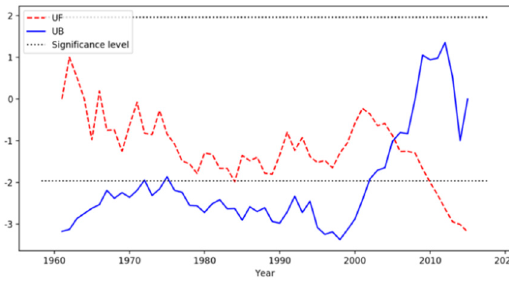
Figure 4. Mann–Kendall (MK) mutation test result.